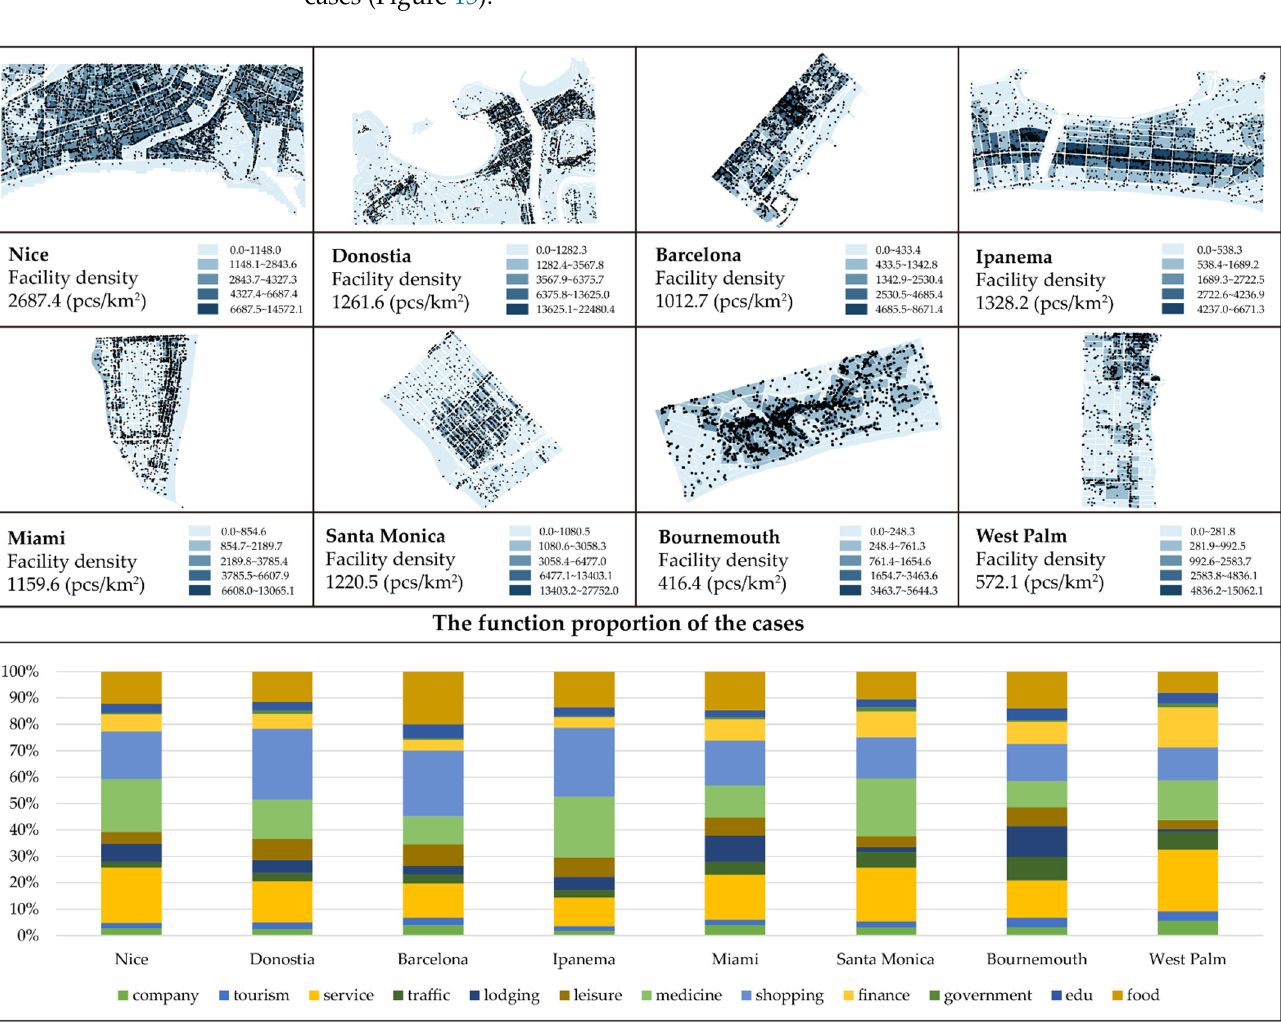
Figure 15. The distribution of facility density and the function proportion in successful coastal cases.